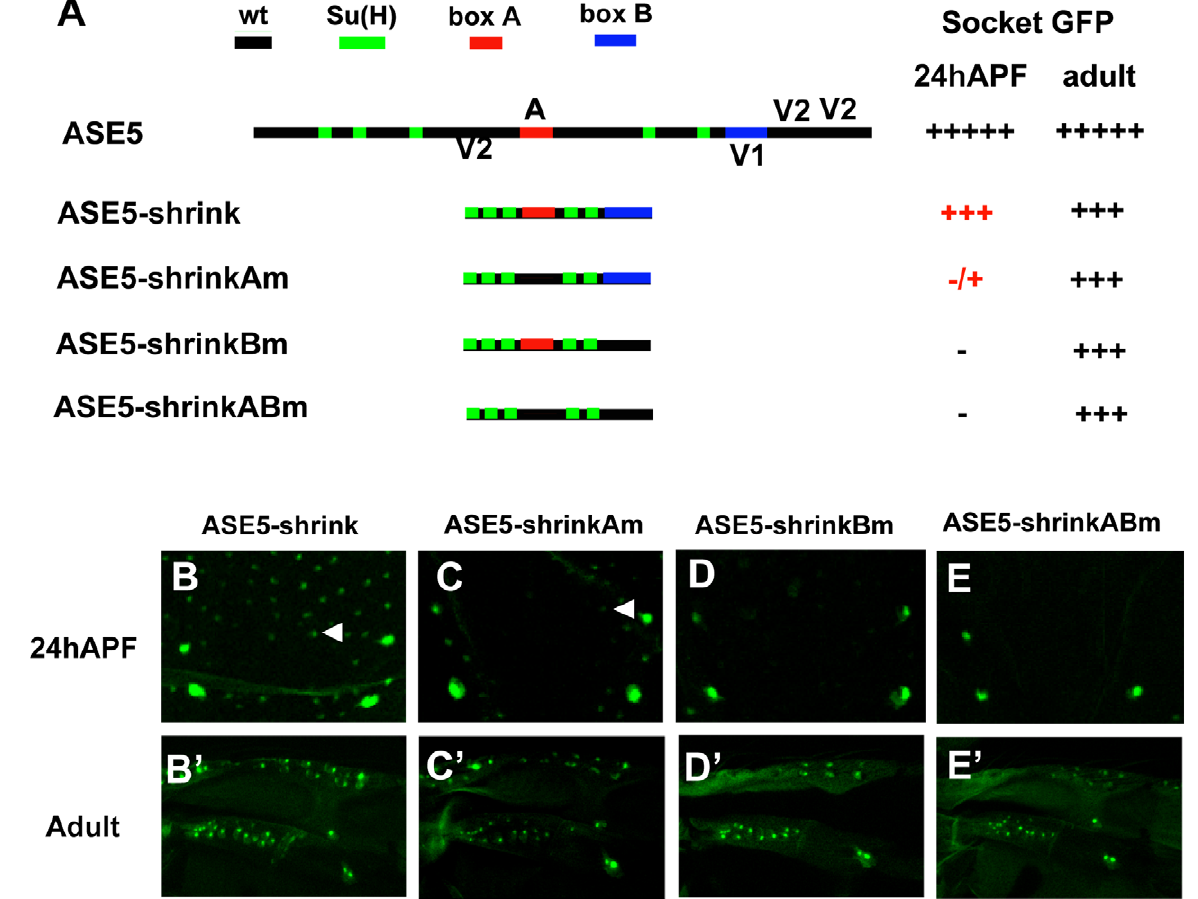
Figure 3. More compact positioning of required motifs in ASE5 increases their activity. (A) Diagrams of ASE5-GFP reporter gene constructs in the ‘‘shrink’’ series; wild-type ASE5 is shown for comparison. The five Su(H) binding sites are marked in green; box A is in red; box B is in blue. Observed levels of GFP expression in socket cells are summarized at right, using the same semi-quantitative scoring system as in Figure 2. (B–E, B 9 –E 9 ) Reporter gene activities are examined in nascent socket cells of notum microchaetes at 24 hours APF (B–E; see arrowheads in B and C), and in mature socket cells in the anterior proximal wing in adults (B 9 –E 9 ); results are summarized in (A). By comparison to ASE5-core (see Figure 2), ASE5- shrink (B, B 9 ) is significantly more active in nascent pupal-stage socket cells. Nevertheless, the overall combinatorial logic of the enhancer is retained at this stage, as shown by its dependence on box A (Am; C, C 9 ) and box B (Bm; D, D 9 ). Bringing just the five Su(H) sites close together permits moderate activity in adult but not pupal-stage socket cells (ABm; E, E 9 ), in contrast to the behavior of ASE5M2, which is inactive at both stages (see Figure S1).